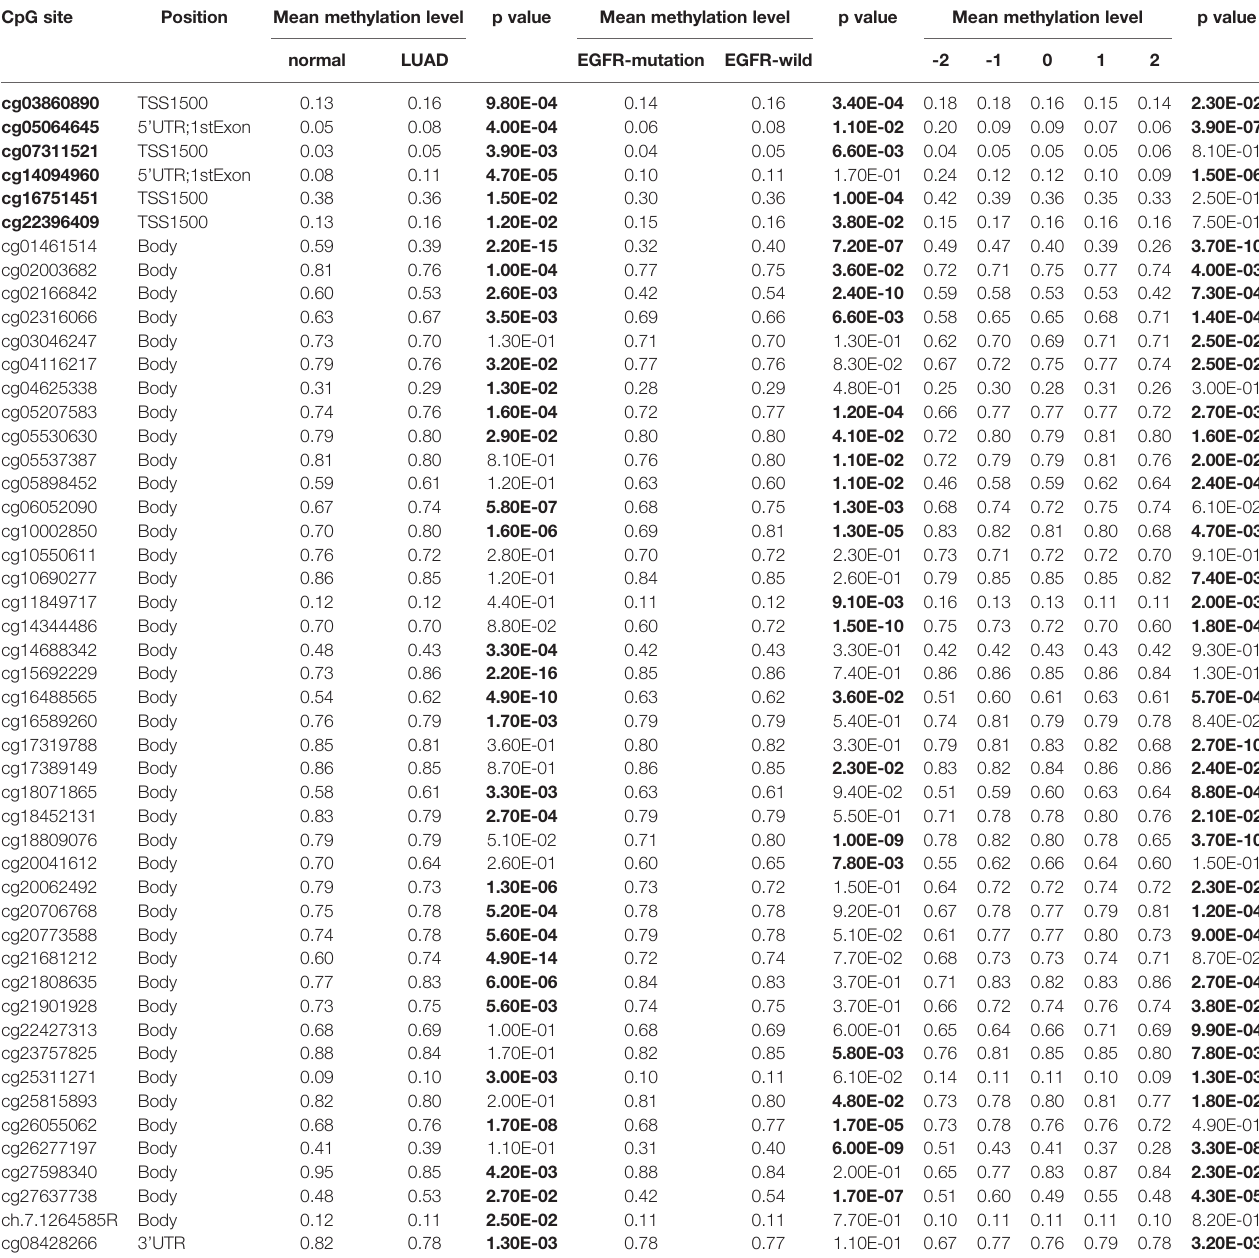
TABLE 2 | Differential methylation levels of EGFR CpG sites among different subgroups. CpG site Position Mean methylation level p value Mean methylation level p value Mean methylation level p value normal LUAD EGFR-mutation EGFR-wild -2